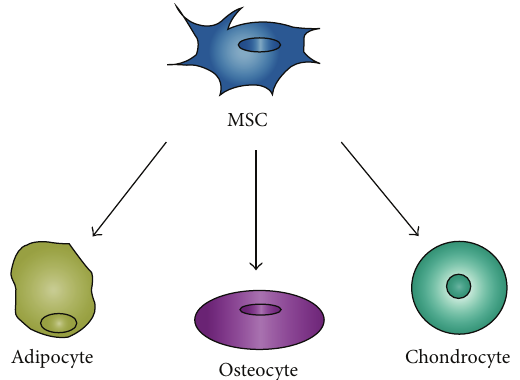
Figure 1: Multipotential differentiation of MSCs into adipogenic, osteogenic, and chondrogenic cell lineages. MSC = multipotent mesenchymal stromal